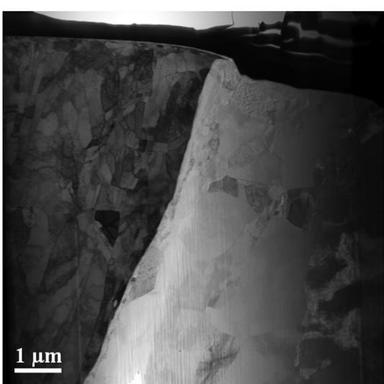
The FIB-TEM analysis image from the Mg/Ni interface display ultra-fine and nano-grains' formation through the magnesium matrix and fragments of nickel foil layers after AFF treatment.